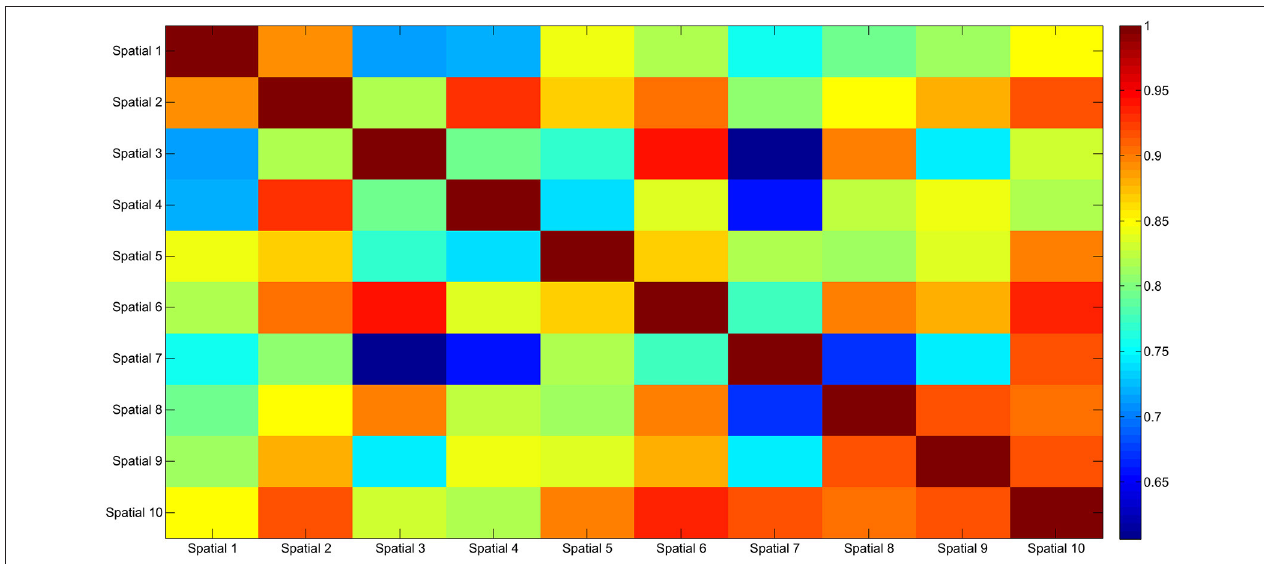
FIGURE 8 | Mean spatial synergy correlation matrix. The matrix identifies the variability between all the pairs of spatial modules, assessed with the dot product. The paired similarity is always > 0.60, indicating that the some muscle components are shared between centroid